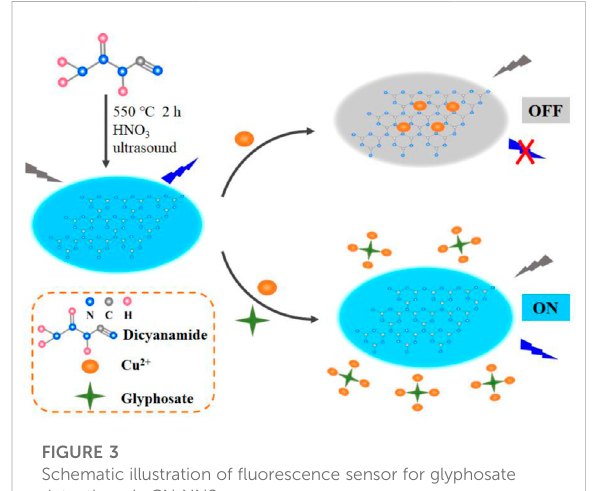
FIGURE 4 Fluorescence emission spectra of different sample